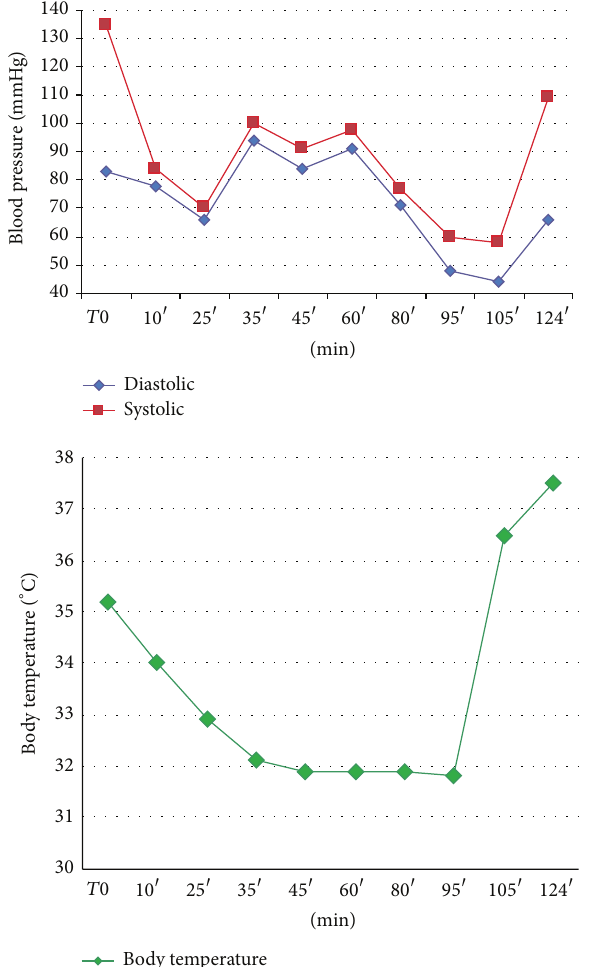
Figure 3: ECC body temperature and blood pressure